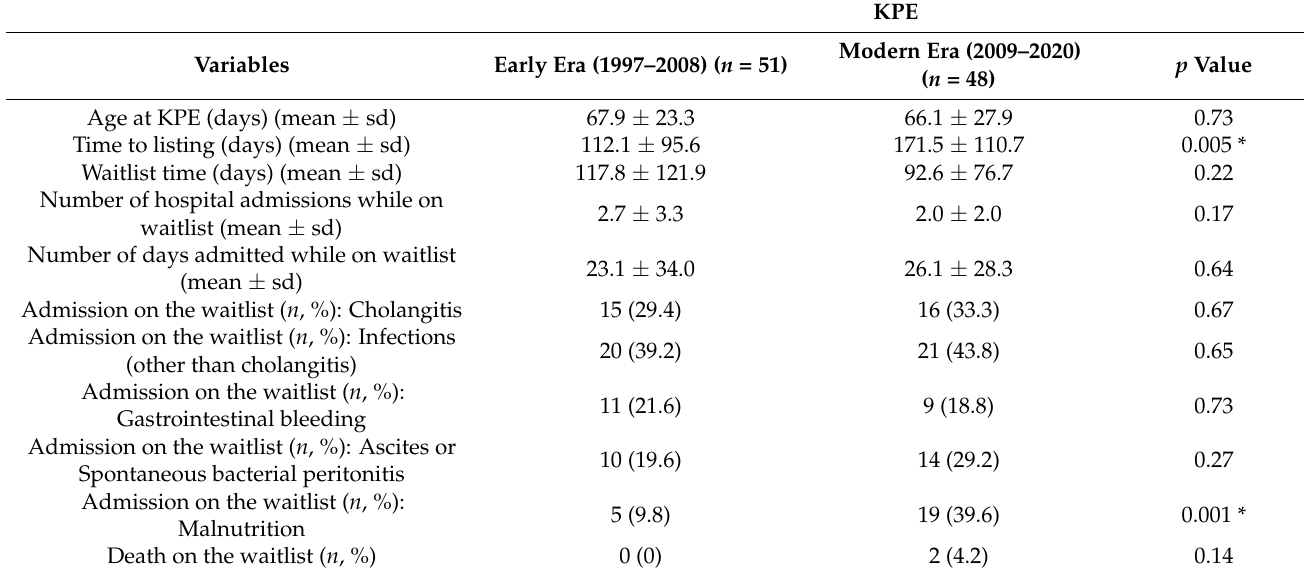
Table 5. Pre-transplant comparison of patients transplanted after KPE based on era: demographics, diagnosis of BA and waitlist-related data. Legend: (*) represents a statistically significant result.